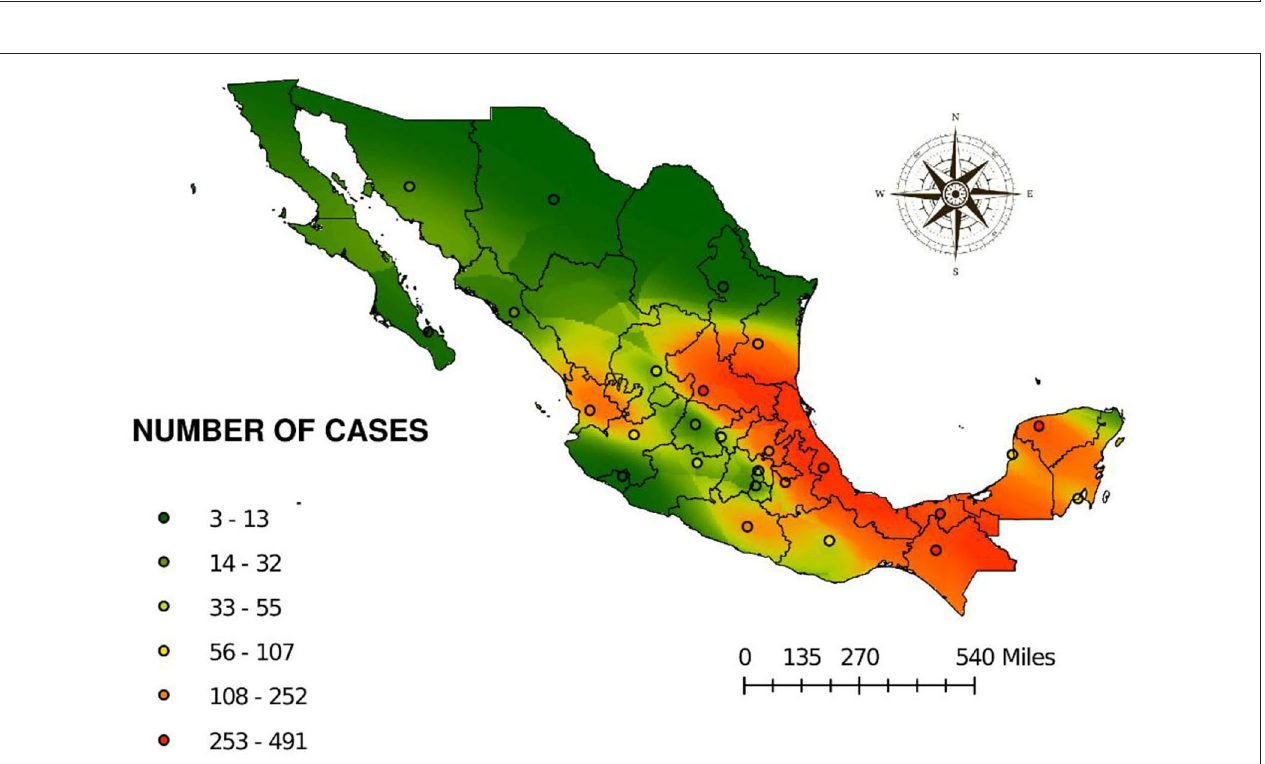
FIGURE 5 | Prediction of risk to cases of rabies in different species from 2010 to 2019 by ordinary kriging.